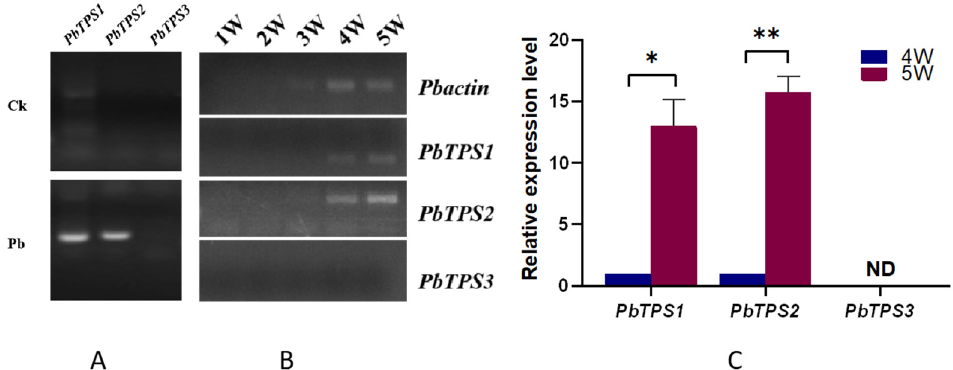
Figure 8. Analysis PbTPS genes in the Chinese cabbage root after P. brassicae infection. ( A ) Reverse- transcription polymerase chain reaction analysis of the expression of PbTPS in infected and healthy plants roots, the template of PCR reaction was root cDNA mixture from 1 week to 5 weeks post- inoculation (wpi). CK: heathy plants; Pb: infected plants. ( B ) Real-time PCR analysis of the expression of PbTPSs in infected plants roots. 1W–5W represent five time points from 1 week to 5 weeks post-inoculation with P. brassicae. ( C ) qRT-PCR analysis of the expression of PbTPSs in infected plants roots at 4 wpi and 5 wpi. Values represent the mean and standard deviation of triplicate results. “ND” means not detected. Asterisks indicate values that are statistically significantly different from the 4 wpi using Student’s t test. (* p < 0.05; ** p < 0.01).